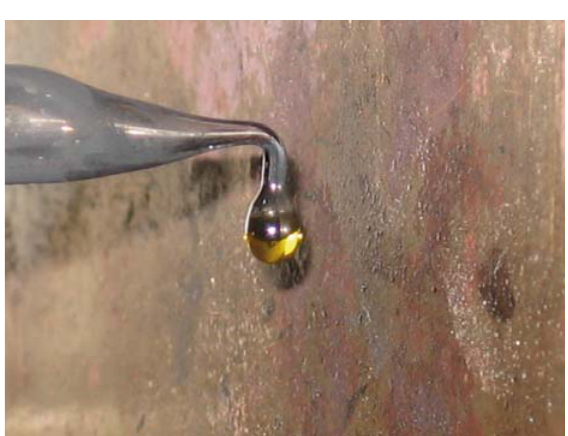
Fig. 1. Fuel droplet combustion stand scheme: 1 – furnace, 2 – suspension device, 3 – ambient temperature measuring sensor, 4 – potentiometer, 5 – photoelectric cell, 6 – synchronising contacts, 7 – stopwatch, 8 – radiant, 9 – screen, 10 – binoculars, 11 – defl ective rails